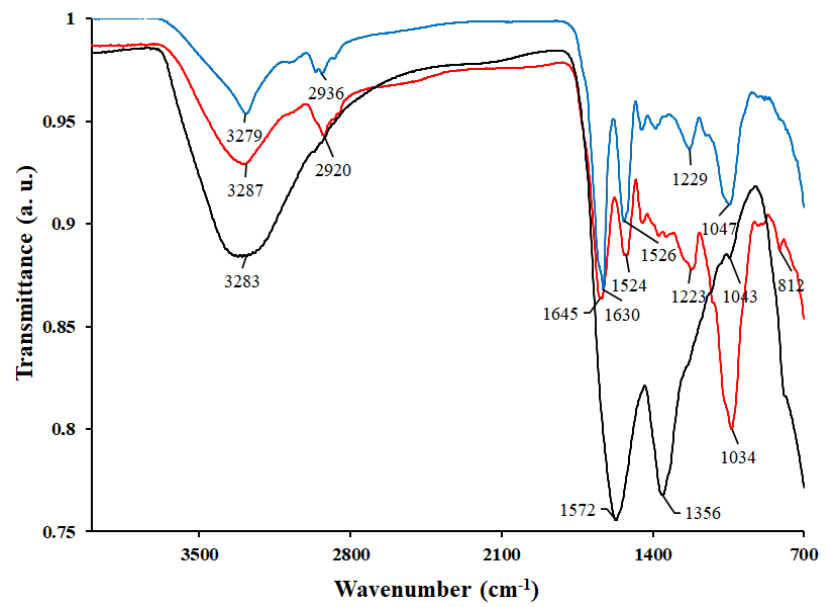
Figure 1. FT-IR spectra of melanins extracted from L. pulmonaria (red line); L . retigera (blue line); S. officinalis (black line). S. officinalis (black line).